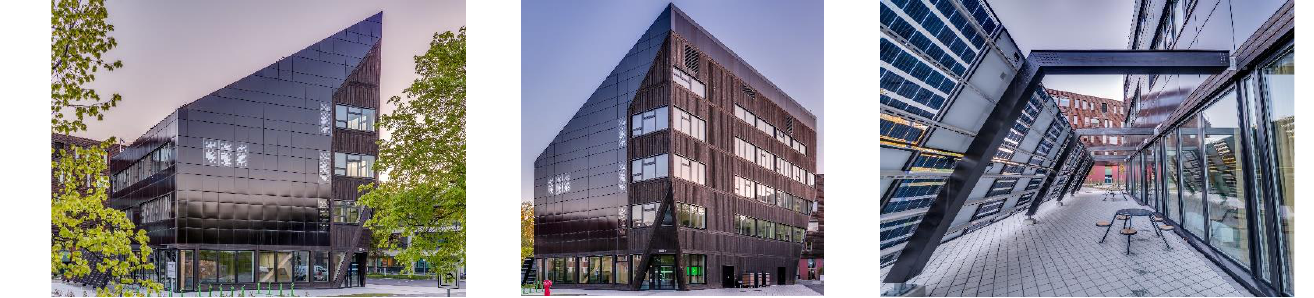
Figure 3. Pictures of the case study building. Copyright: Nicola Lolli/SINTEF.